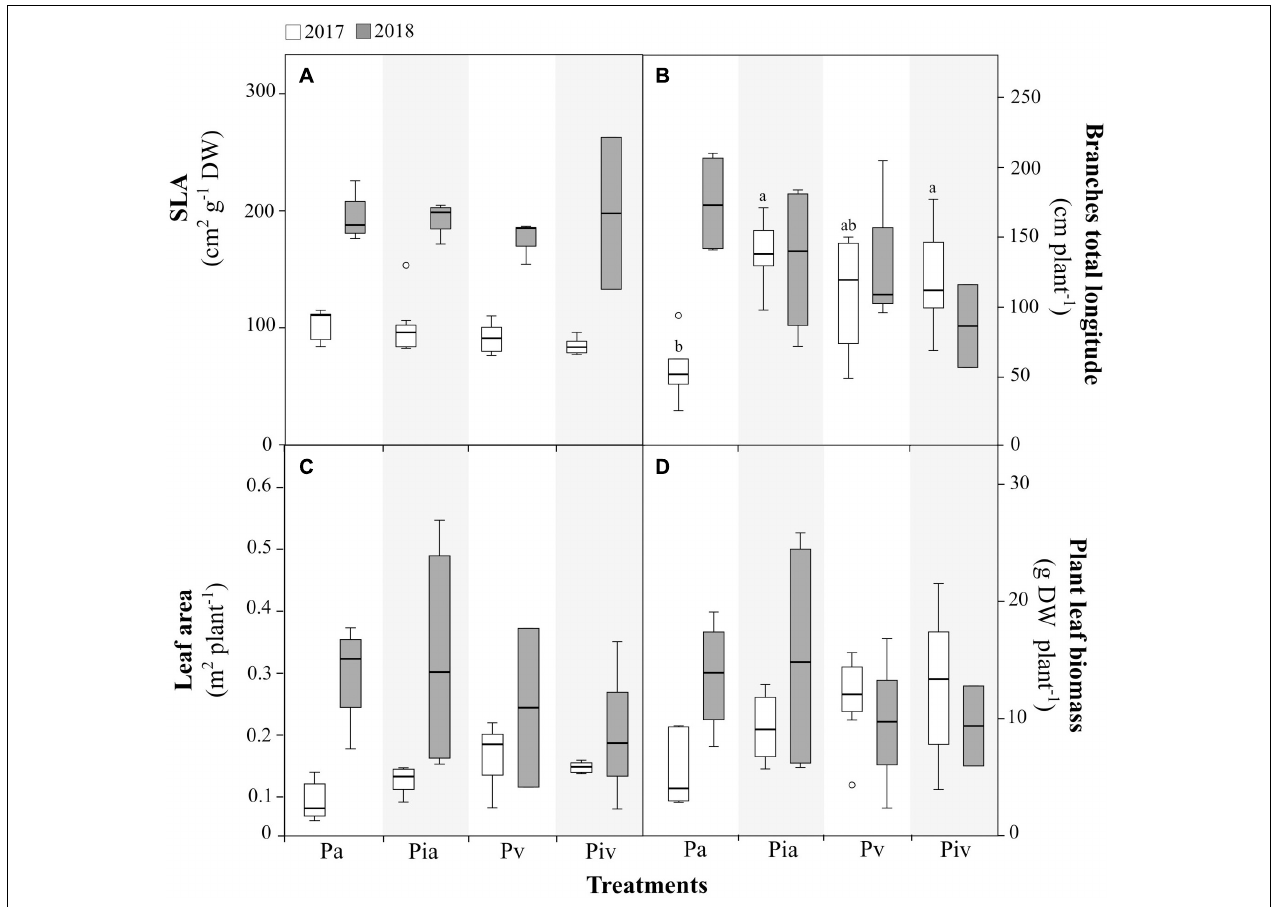
FIGURE 2 | Biometric parameters in poplar (Populus × canadensis) saplings in 2017 (open bars) and 2018 (closed bars). Treatments: Pa, intercropping of non-mycorrhizal poplars with alfalfa; Pia, intercropping of mycorrhizal poplars with alfalfa; Pv, planting of non-mycorrhizal poplars with spontaneous vegetation; and Piv, planting of mycorrhizal poplars with spontaneous vegetation. (A) Specific Leaf Area (SLA); (B) Total branch length; (C) Plant leaf area; (D) Plant leaf biomass. Small letters indicate significant differences between treatments in 2017 ( p < 0.05). In 2018, there were no statistically significant differences between treatments. Each bar represents the mean ± SE ( n =